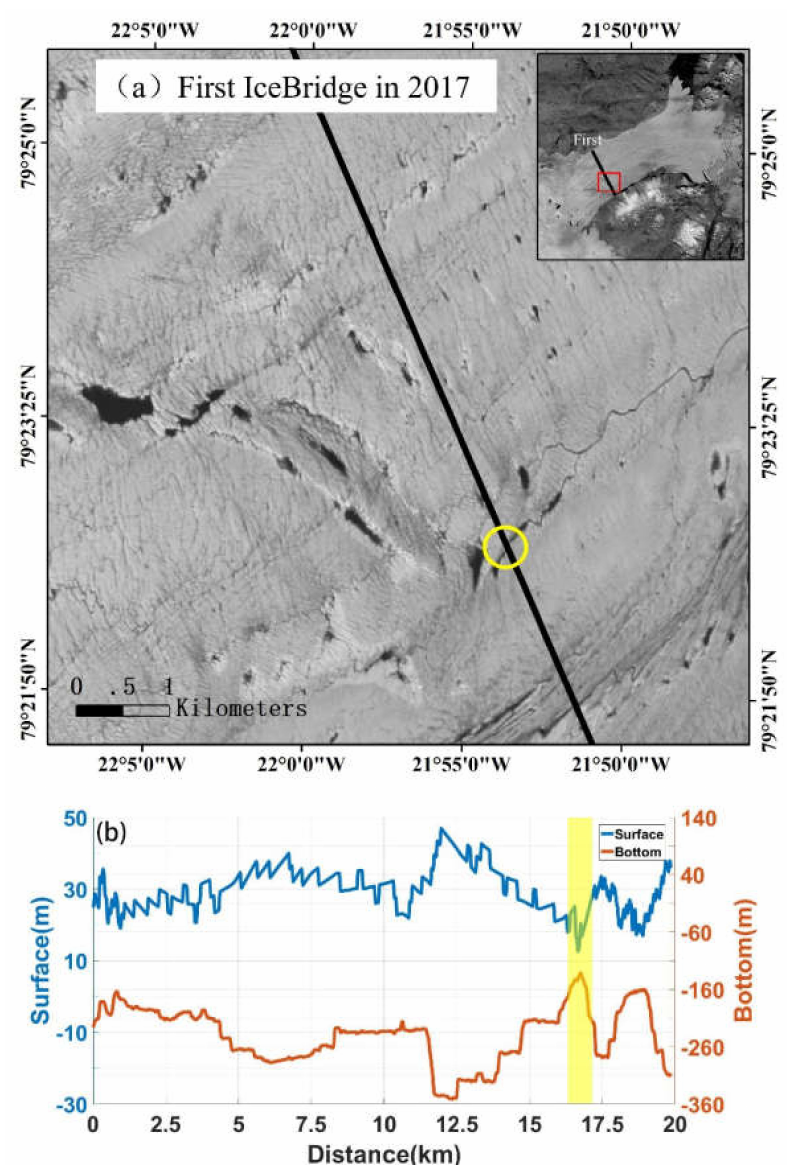
Figure A3. The first IceBridge in 2017 validates the data and Landsat imagery. ( a ) shows the surface morphology at the first IceBridge data in 2017, with IceBridge airborne radar flight path (black solid line). The location indicated by the yellow circle is the area confirming the existence of the basal channel. ( b ) shows the results from the first IceBridge in 2017. The yellow area corresponds to the yellow circle in ( a